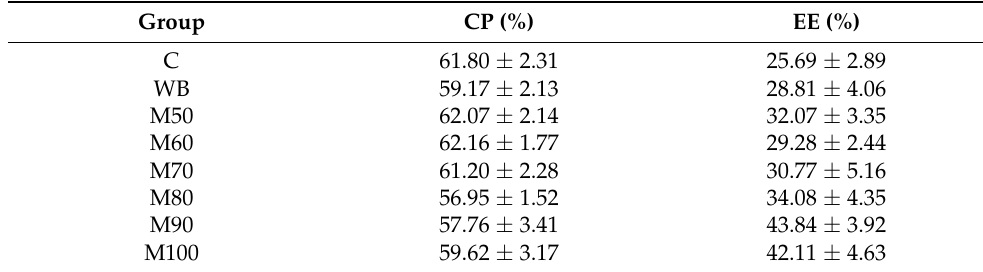
Table 8. Crude protein and ether extract of BSF larvae in Experiment